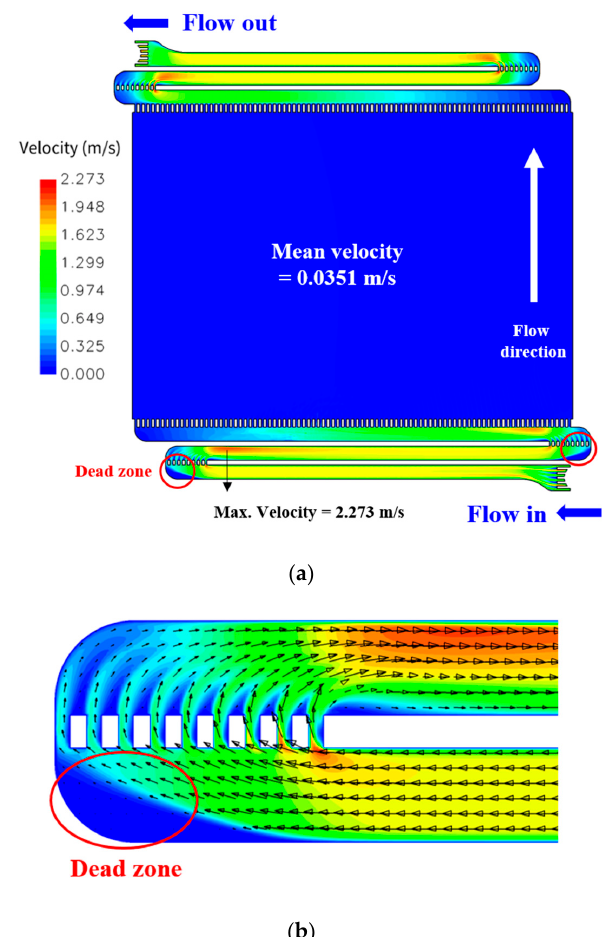
Figure 9. Velocity distribution in the basic configuration of vanadium redox flow battery. ( a ) Flow distribution; ( b ) Velocity vectors in the curved section of the S-shaped inlet channel.